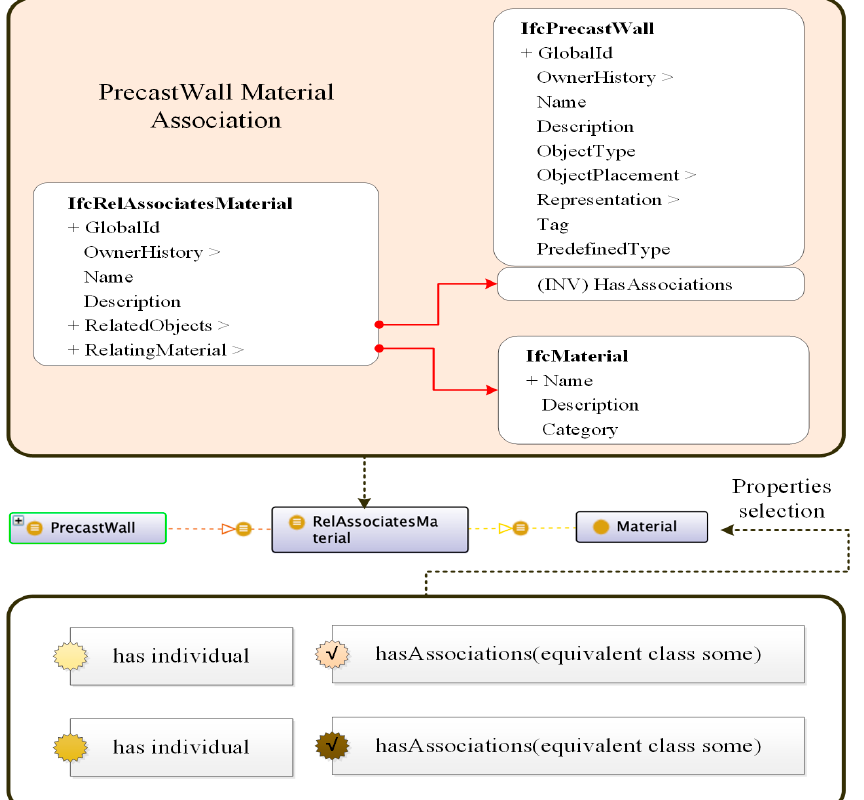
Figure 25. Prefabricated wall components and materials conceptual drawing.